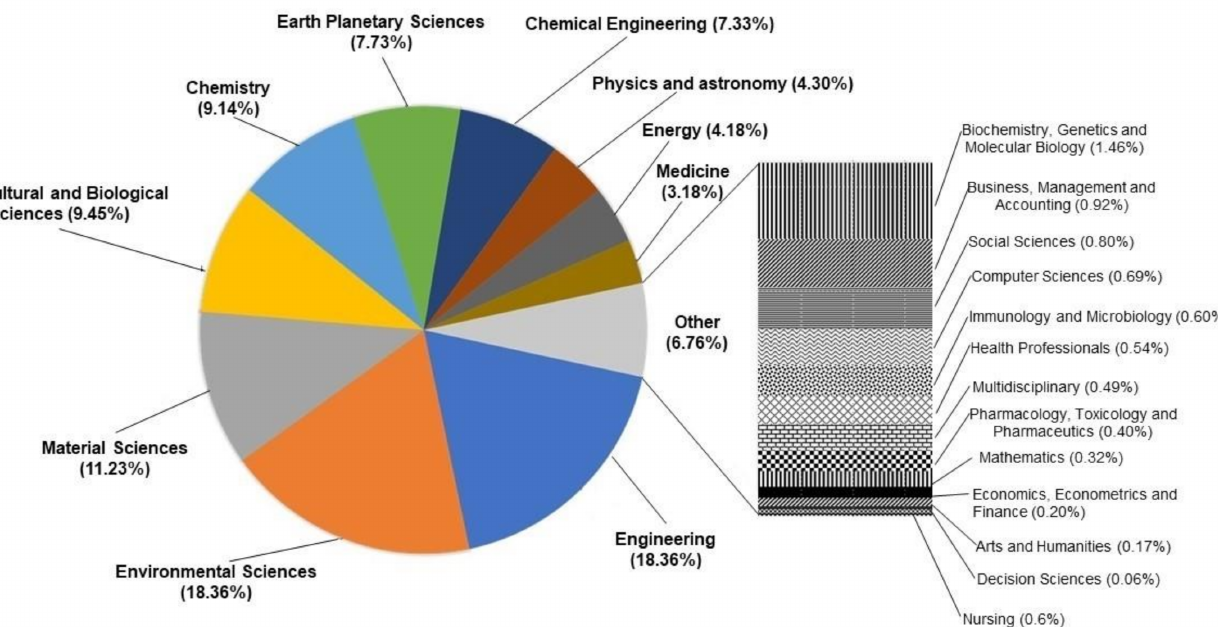
Figure 2. Papers in the field of “phosphogypsum” classified by fields (Scopus Database).